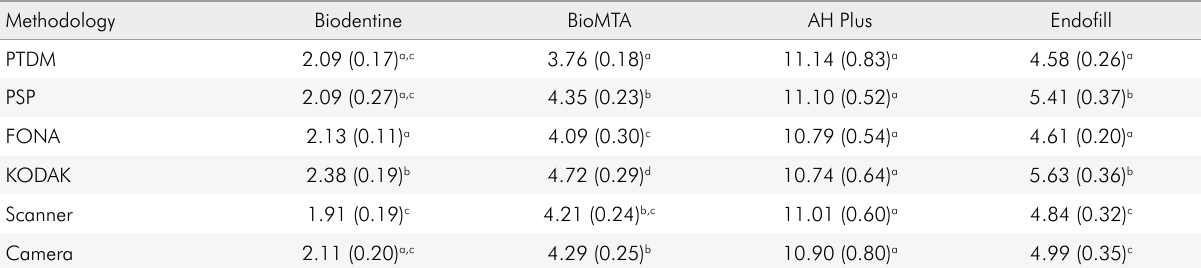
Table 4. Radiopacity (mean and SD) calculated with the quadratic model in mm Al, comparing ODU values of the PTDM (converted to grayscale) with the grayscale values of all methodologies used.